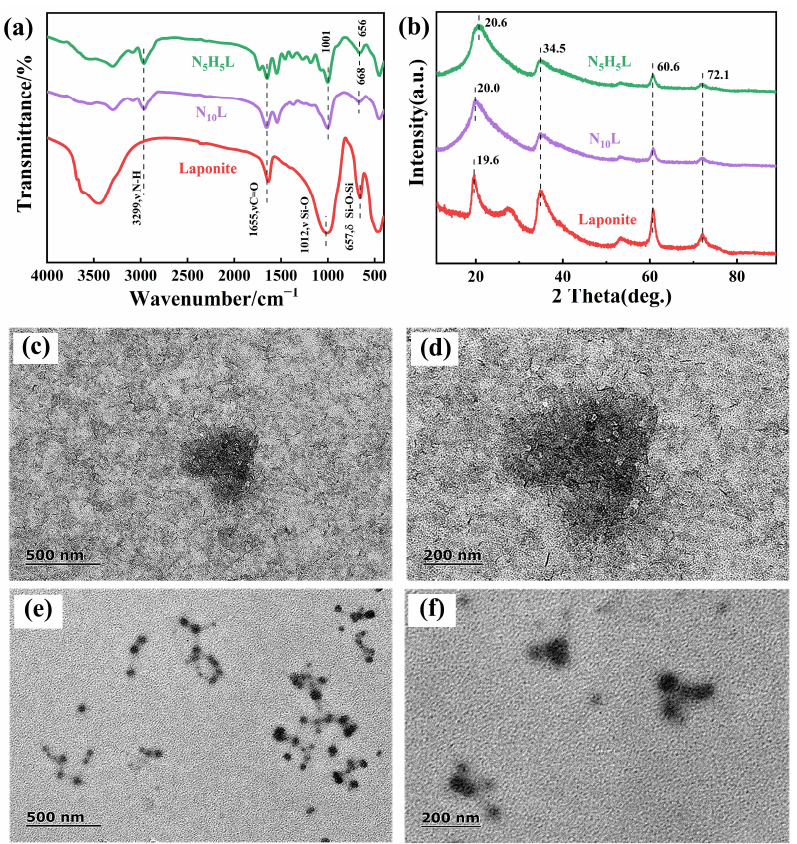
Figure 2. ( a ) FTIR spectra of pre-hydrogels; ( b ) XRD spectra of pre-hydrogels; ( c , d ) HR-TEM of